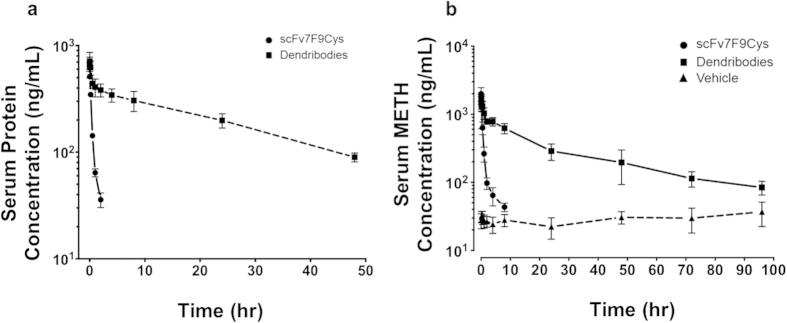
a Serum concentration-time profiles of anti-METH scFv7F9Cys and dendribodies after i.v. bolus dosing at t = 0 min. Average concentration-time profile of anti-METH scFv7F9Cys (closed circles, solid line) and dendribodies (closed squares, dashed line) after i.v. bolus dosing at t = 0 min. The total amount of antibody (μg/ml) in the serum was calculated based on the ratio of dose to radiolabeled protein dose (DPM). Connecting lines in the graph are representative and not the fitted curves used for PCKN modeling and determination of final PCKN parameters. b Average concentration versus time profiles for METH in serum with scFv7F9Cys (closed circles), dendribodies (closed squares) or with a control injection of vehicle (closed triangles) administered at t = 0 min. ScFv7F9Cys and dendribodies redistributed METH to the central compartment (vasculature) to cause an immediate increase in the METH concentrations. All groups of rats received an s.c. METH infusion of 3.2 mg/kg/day. All values are represented as the mean ± SEM; n = 6, scFv7F9Cys; n = 5 dendribody group.